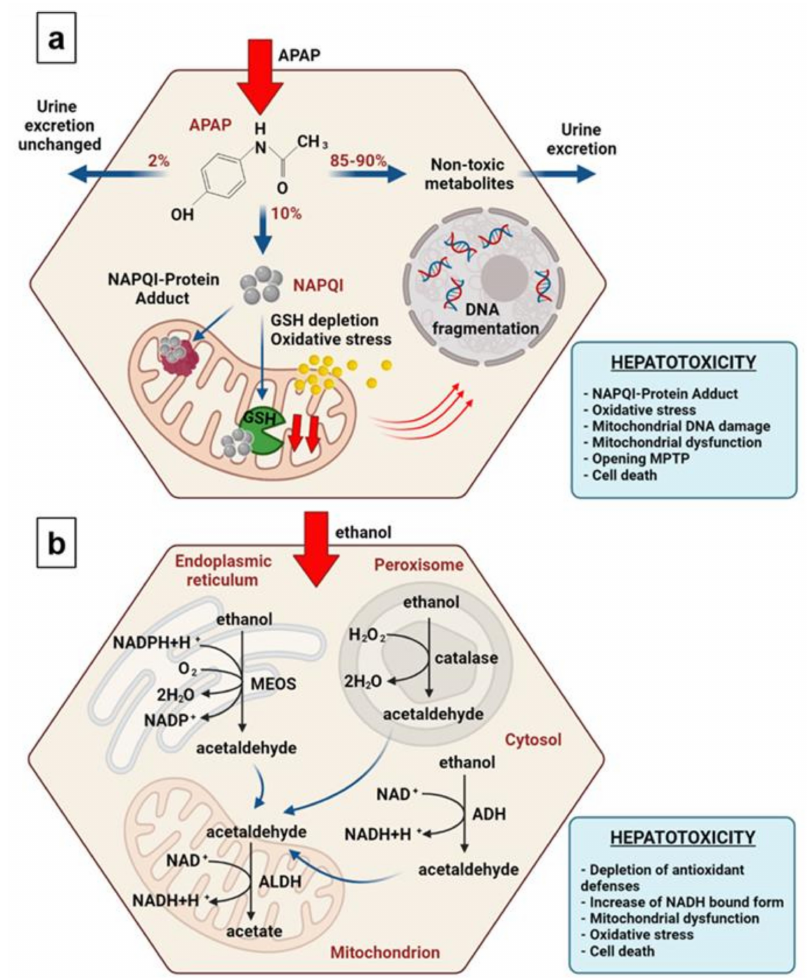
Figure 1. Schematic diagrams of the hepatotoxicity mechanisms. ( a ) APAP and ( b ) ethanol. The percentage distribution of the APAP metabolic pathways is represented by averaged values, and these are in agreement with the published works